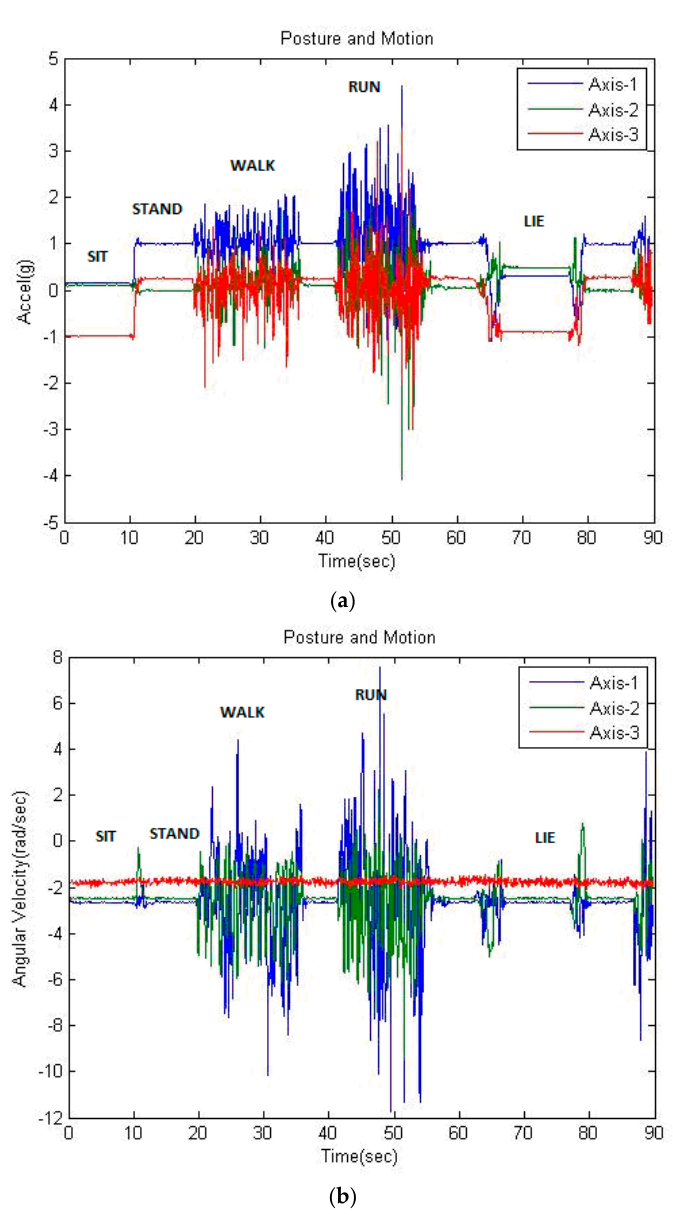
Figure 2. Variations of acceleration in gravity ( a ) and angular velocity in degree/sec ( b ) detected by mote A. mote